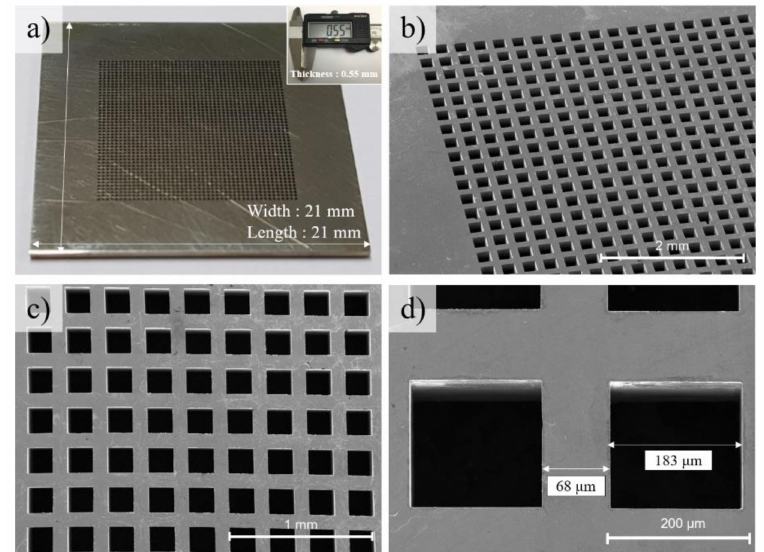
Figure 5. Polished Ni-Fe electroformed mold insert. ( a ) Overall figure; ( b ) diagonal view; ( c ) top view; ( d ) magnified top